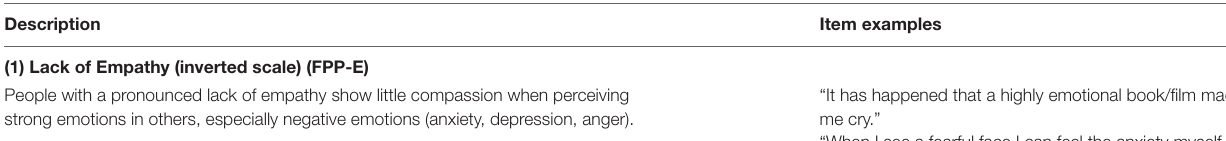
TABLE 1 | Scales and exemplary items of the questionnaire of psychopathic personality traits